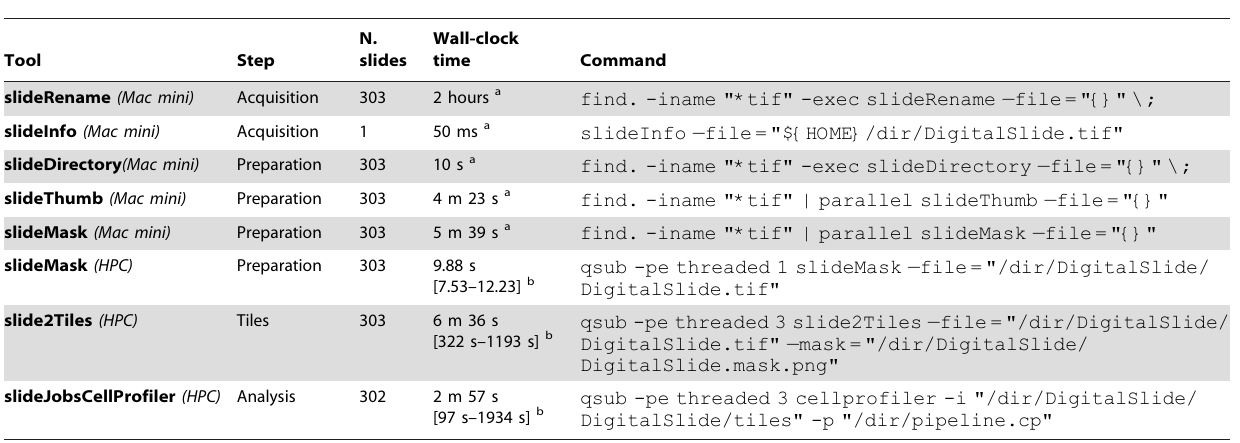
Table 3. Tools used, wall-clock times and instructions.